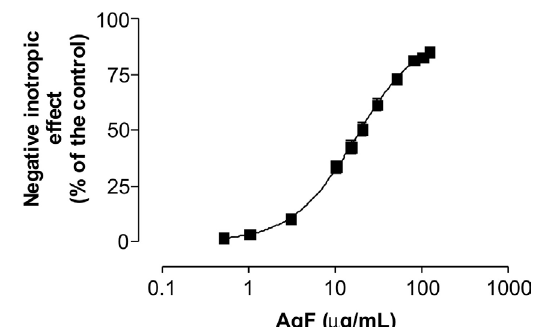
FIGURE 2 - Hill-Lagmuir curve of the depressant effect produced by AqF on the contraction force of guinea pig left atria (n = 4; EC50 = 14.28 ± 3 m g/mL; Relative efficacy: 85 ± 9.4 %; Hill constant: 1.5; 27 ± 0.1 ºC; Stimulation: 2 Hz, 400 V, 0.5